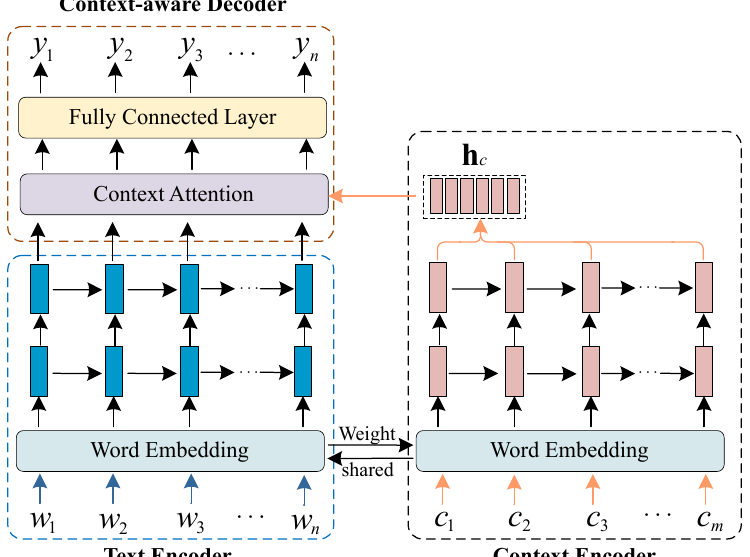
Figure 2. The architecture of the proposed